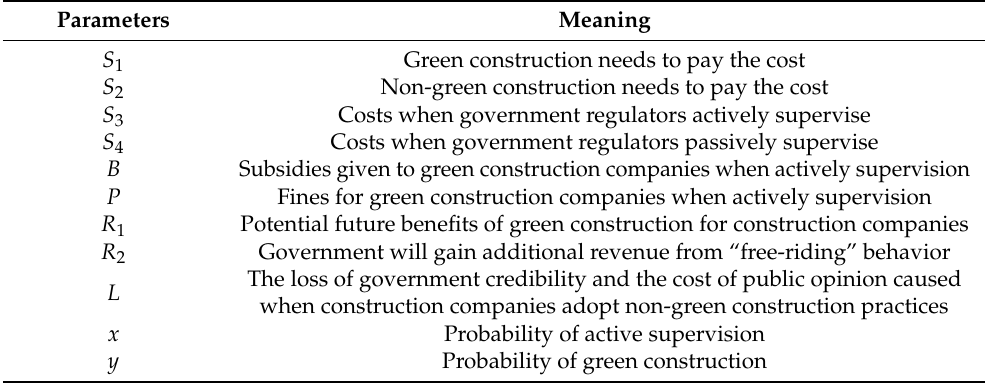
Table 1. Parameter symbols and their meanings.